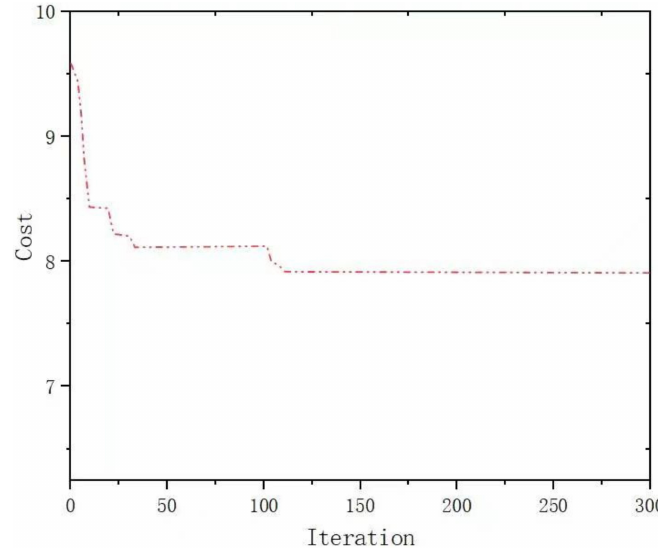
Figure 9. Cost iteration convergence graph for blank dimension 2.